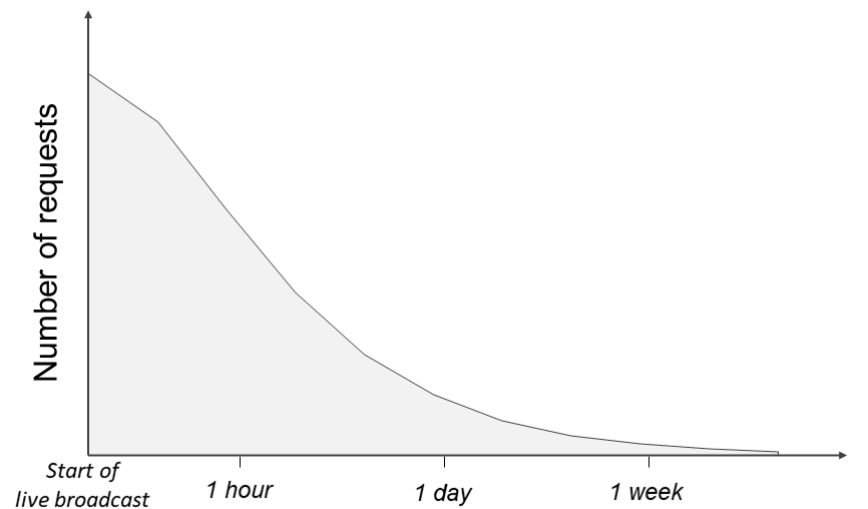
Figure 1. Typical popularity distribution of live broadcast TV